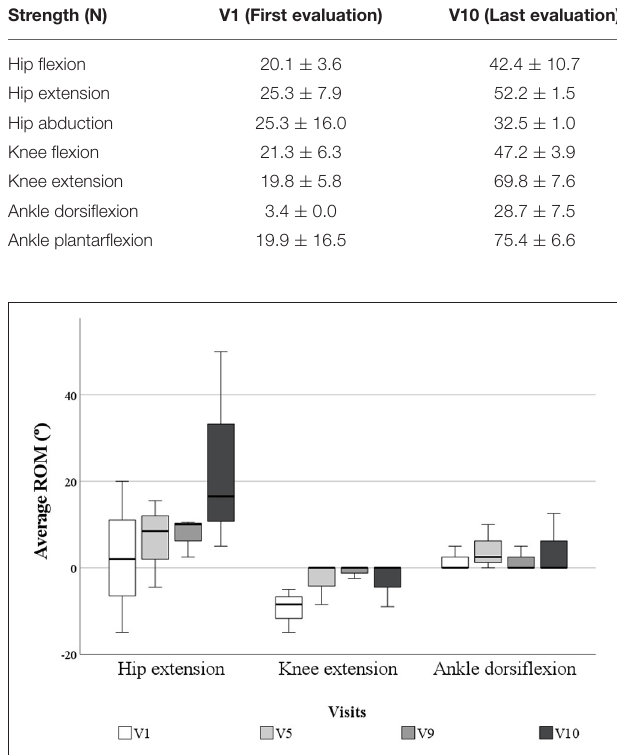
The greatest increases in muscle strength were notable